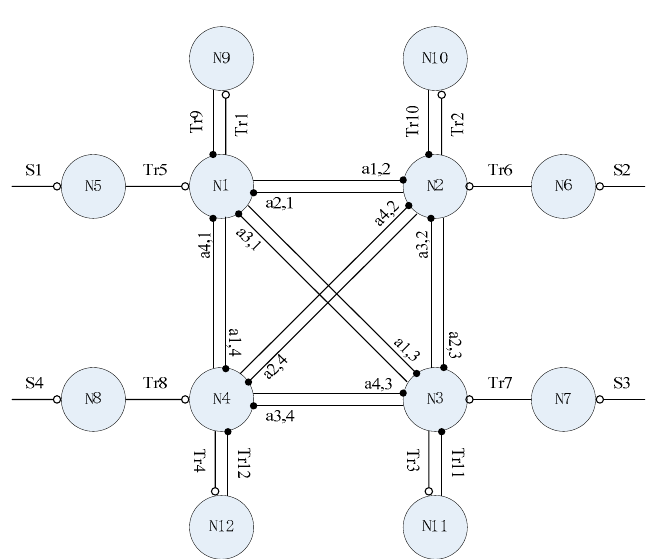
Figure 10. Local Central Pattern Generator (CPG) network connection structure for the hip joint control of a quadruped robot.